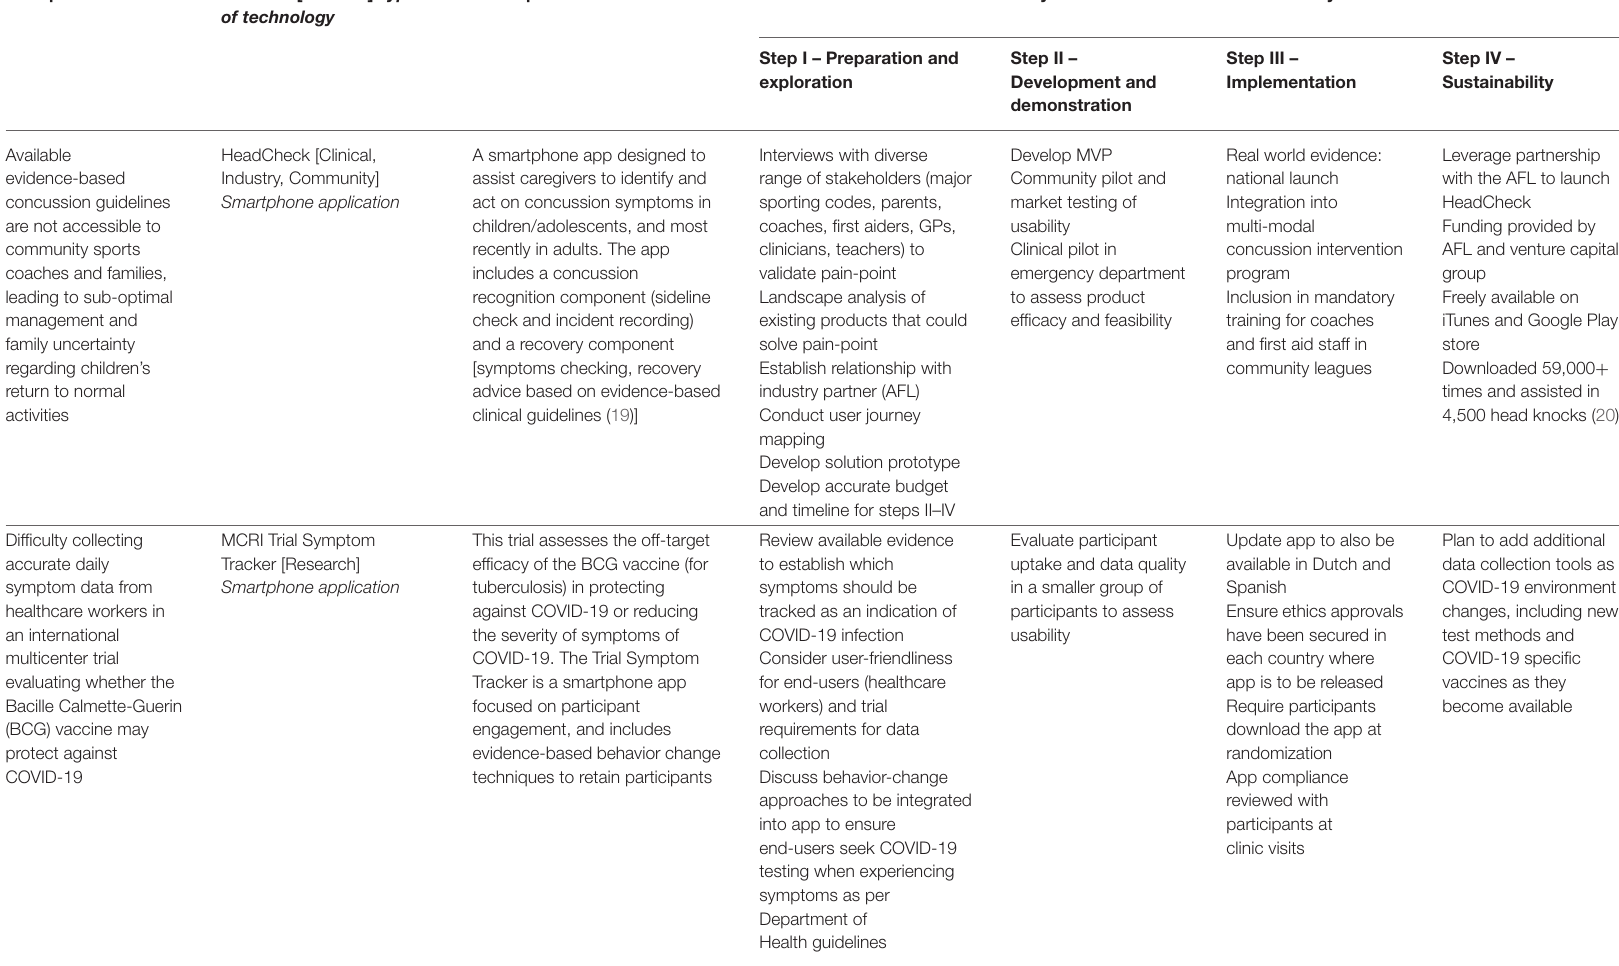
TABLE 1 | Description of DHTI